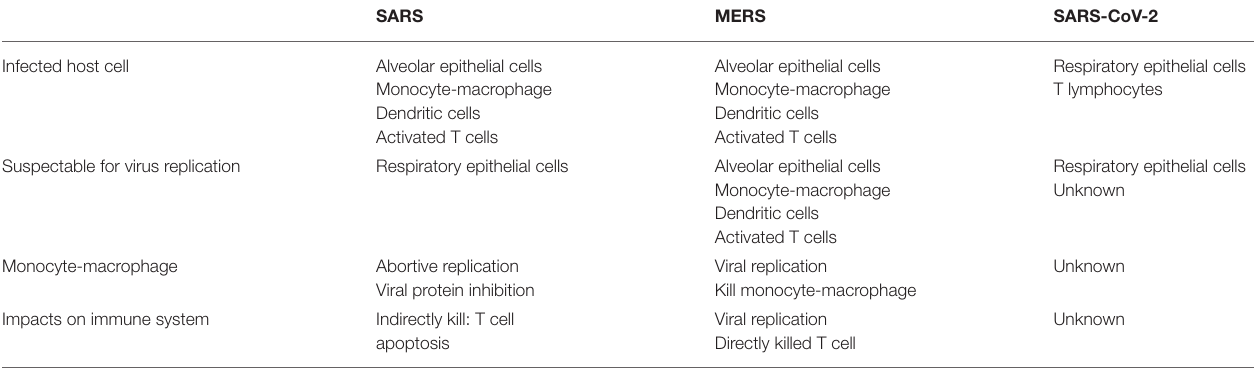
TABLE 1 | Immunology differences between SARS-CoV, MERS-CoV, and SARS-CoV-2. SARS